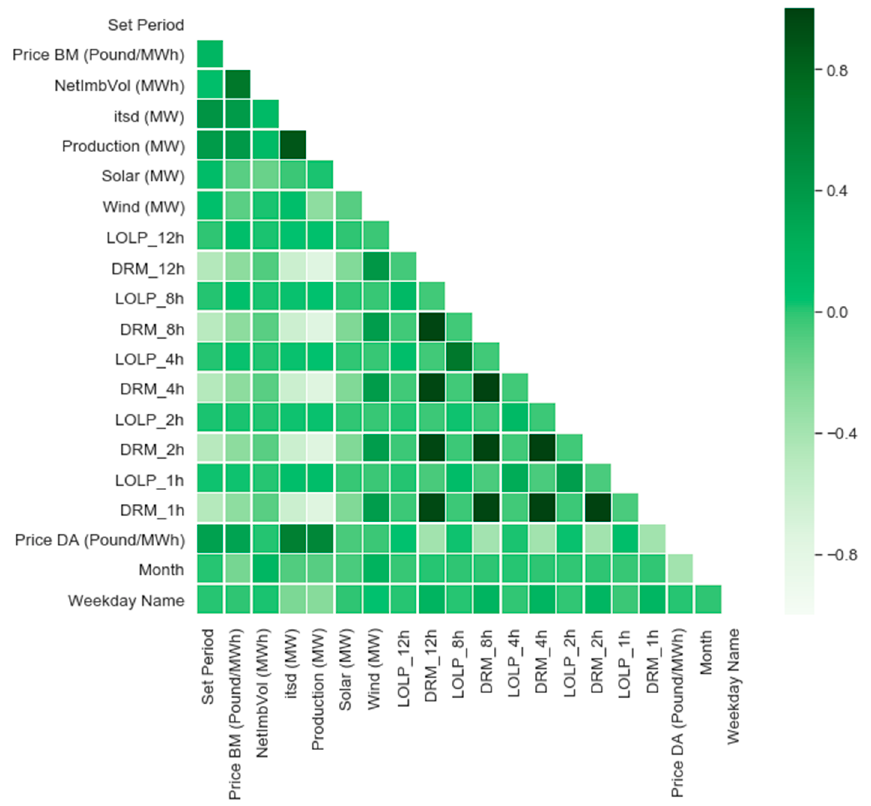
Figure 2. Correlation matrix of input variables.